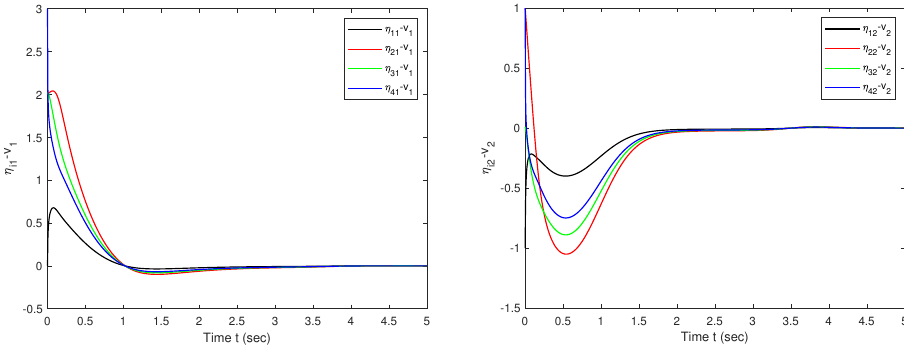
Figure 2. The error output of the adaptive dynamic observer η i 1 − v 1 and η i 2 − v 2 , i = 1,2,3,4.